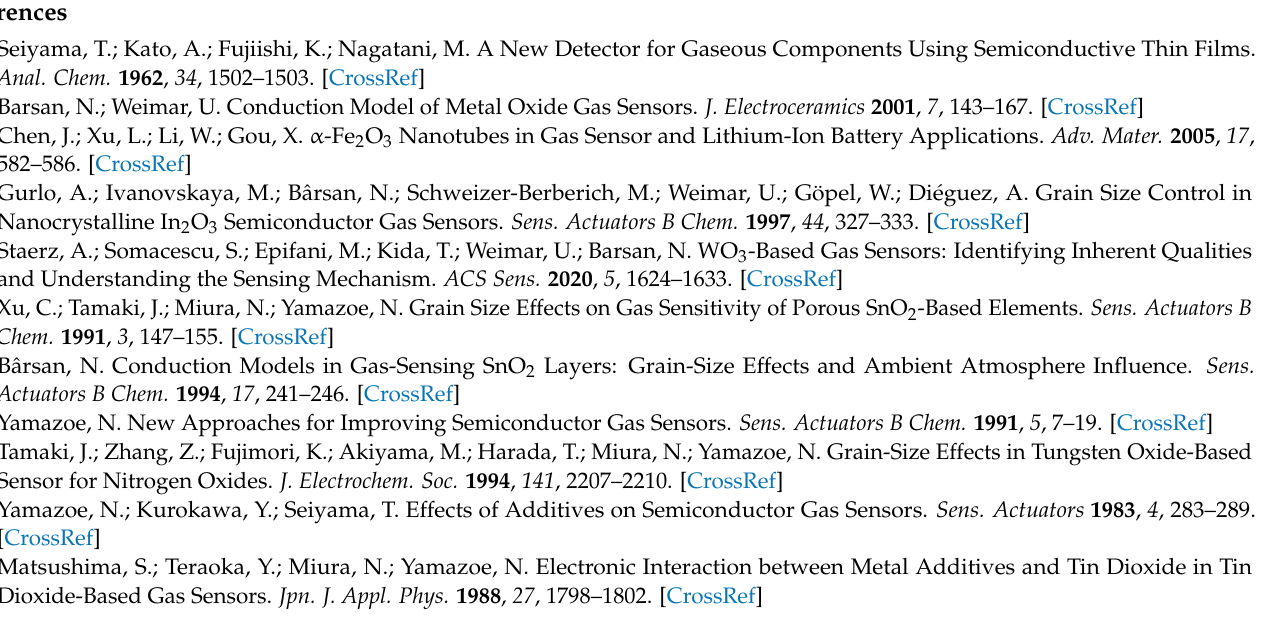
Figure S2: Colloidal size distributions of Pt-ZnO NCs in toluene; Figure S3: EDS spot spectra of Pt-ZnO NCs; Figure S4: Cross-sectional SEM images of the sensor devices made of Pt-ZnO NCs; Figure S5: Temperature dependence of the sensor response; Table S1: Pt loading amounts on ZnO